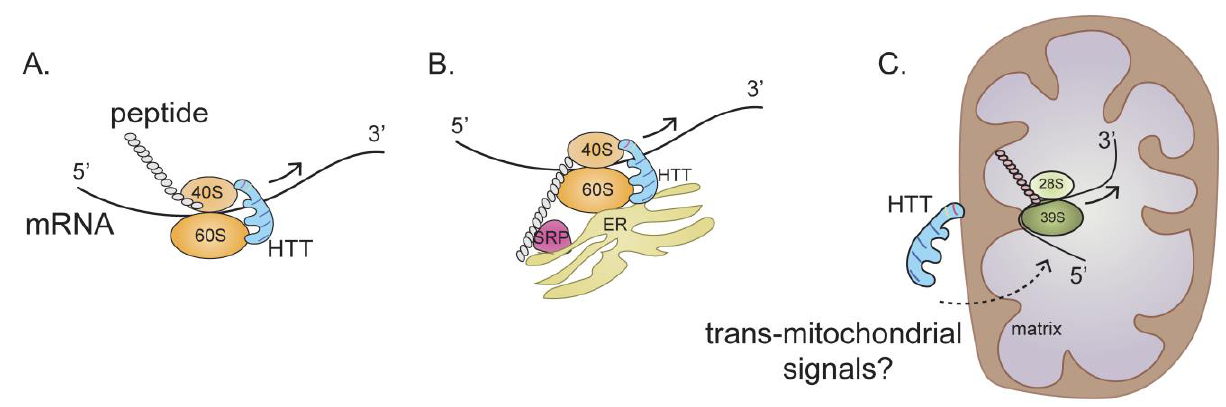
FIGURE 2: HTT (wtHTT and mHTT) binds to 40S and 60S ribosomal subunits and regulates the ribosome movement by acting as “molecular brake” thereby altering the ribosomal occupancy of selected cytoplasmic mRNAs (A), ER-associated mRNAs (B), and mitochondrially- encoded OXPHOS mRNAs (C). HTT is depicted as scaffolding protein. Arrow indicates the direction of ribosomal movement. Dotted arrow indicates potential signals through which HTT may. regulate mitochondrial mRNAs ribosome translocation. See text for